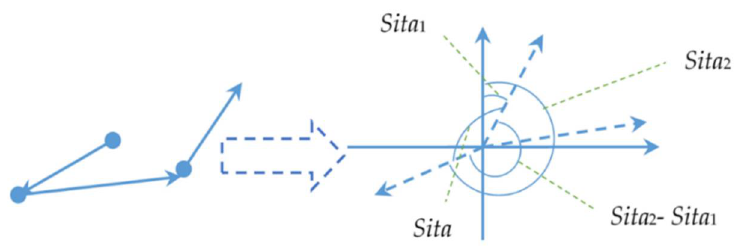
Figure 8. Illustration of (i).